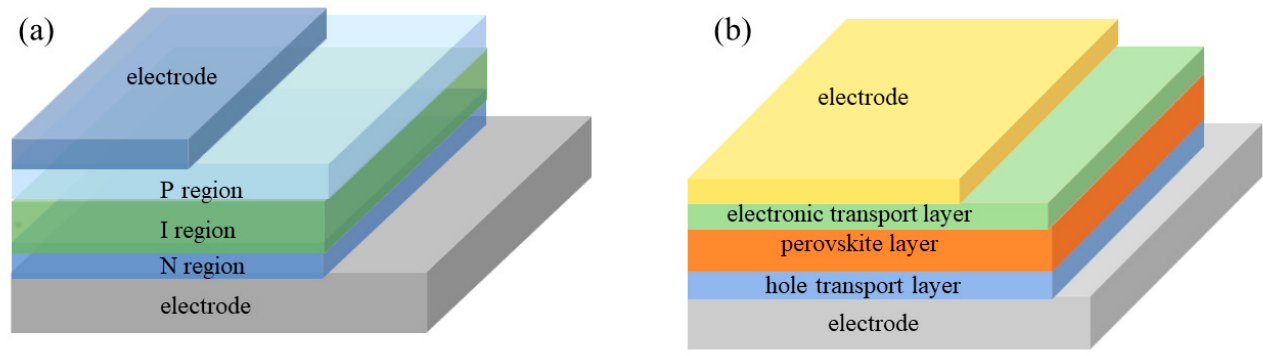
Figure 5. Structure diagram of the perovskite phototransistor.